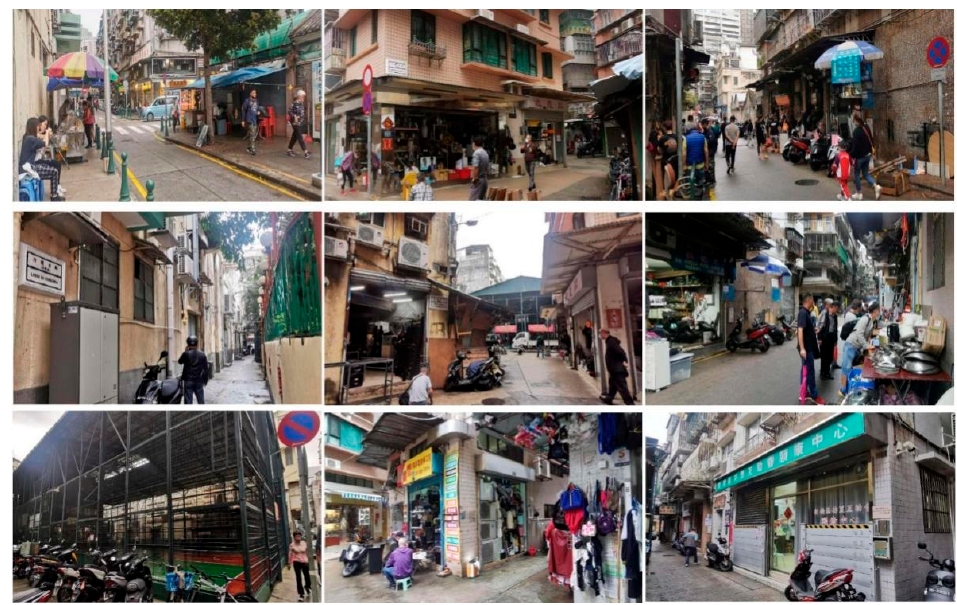
Figure 11. Largo do Aquino and Largo do Lilau.